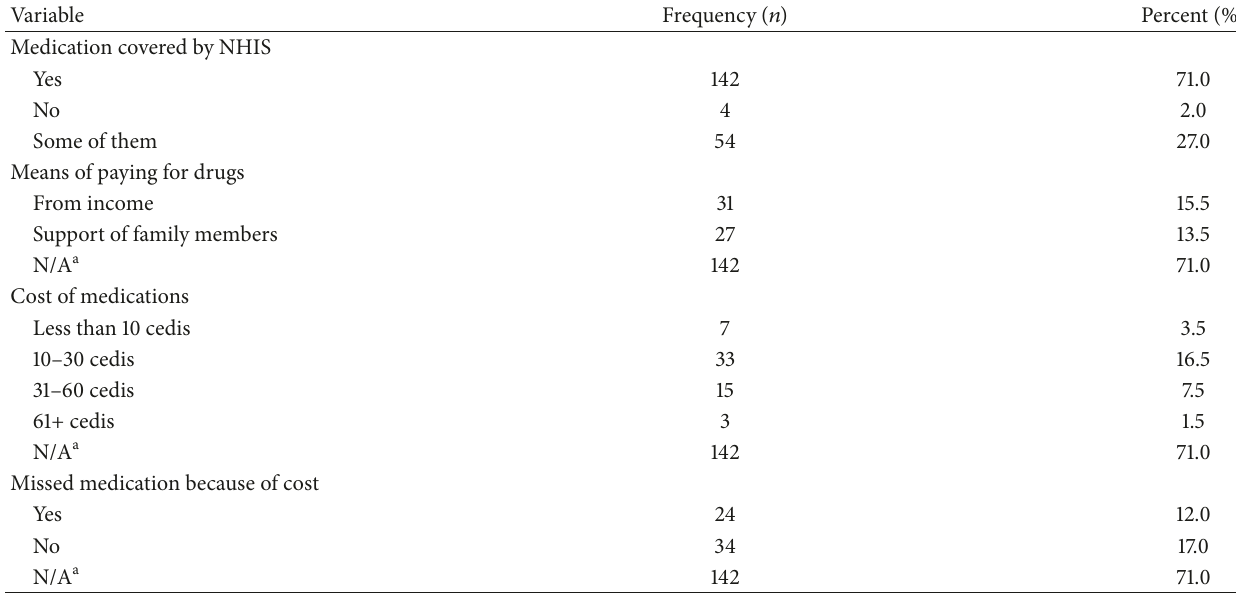
Table 3: Cost and medication noncompliance ( 𝑁 = 200